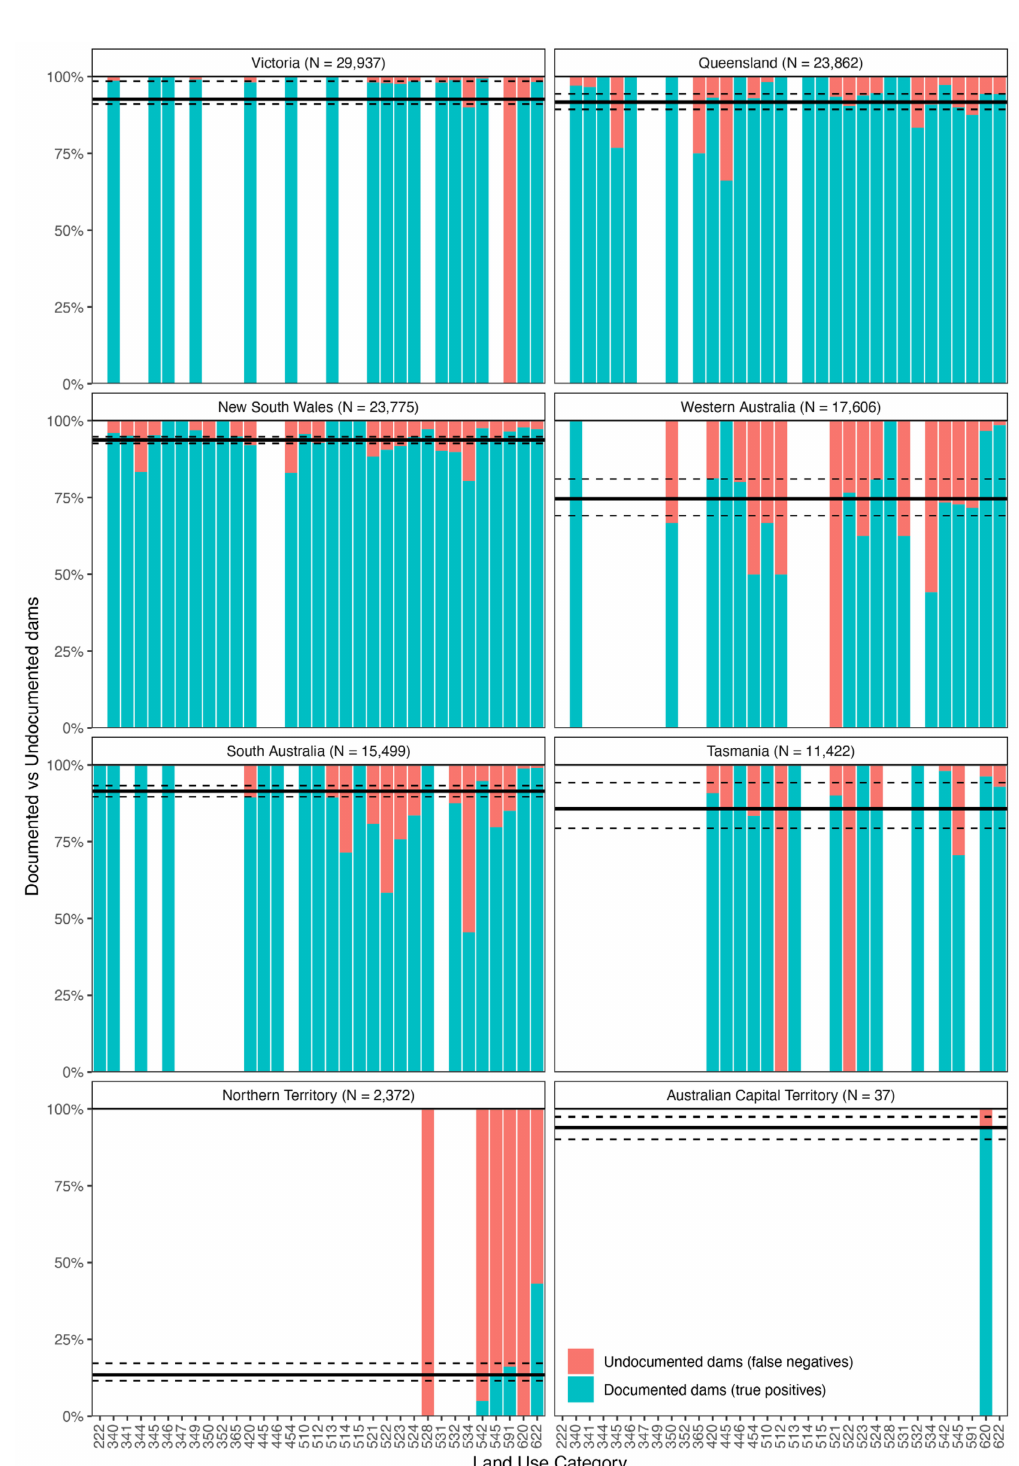
Figure 4. Frequency of undocumented farm dams (false negatives) encountered in the 33 agricultural land types with the highest reported dam densities (>2 dams km − 2 ) across Australia (see Figure S2 for the names of the land use categories used in this analysis). We searched for dams by randomly sampling sites among these land use types. The number of searched sites in each region is reported in the facet title. Horizontal lines indicate overall percentages of detected dams across all land use types over the total ( ± bootstrapped 95% confidence intervals). Missing columns indicate land use categories that are absent from the State or